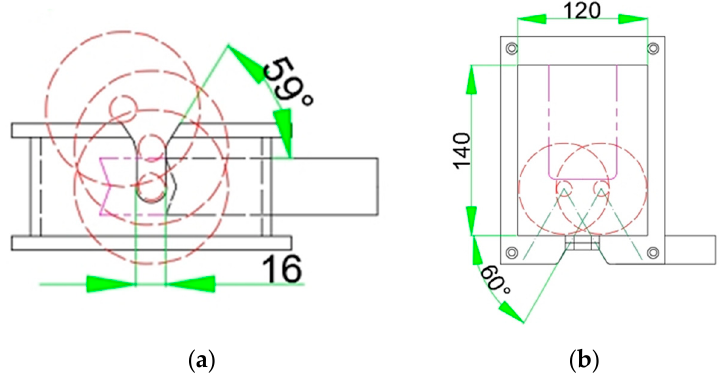
Figure 3. Design of end-effector: (a) frontal view; (b) plane view (black lines: end-effector contour, red lines: examples of sweet pepper’s fruit).